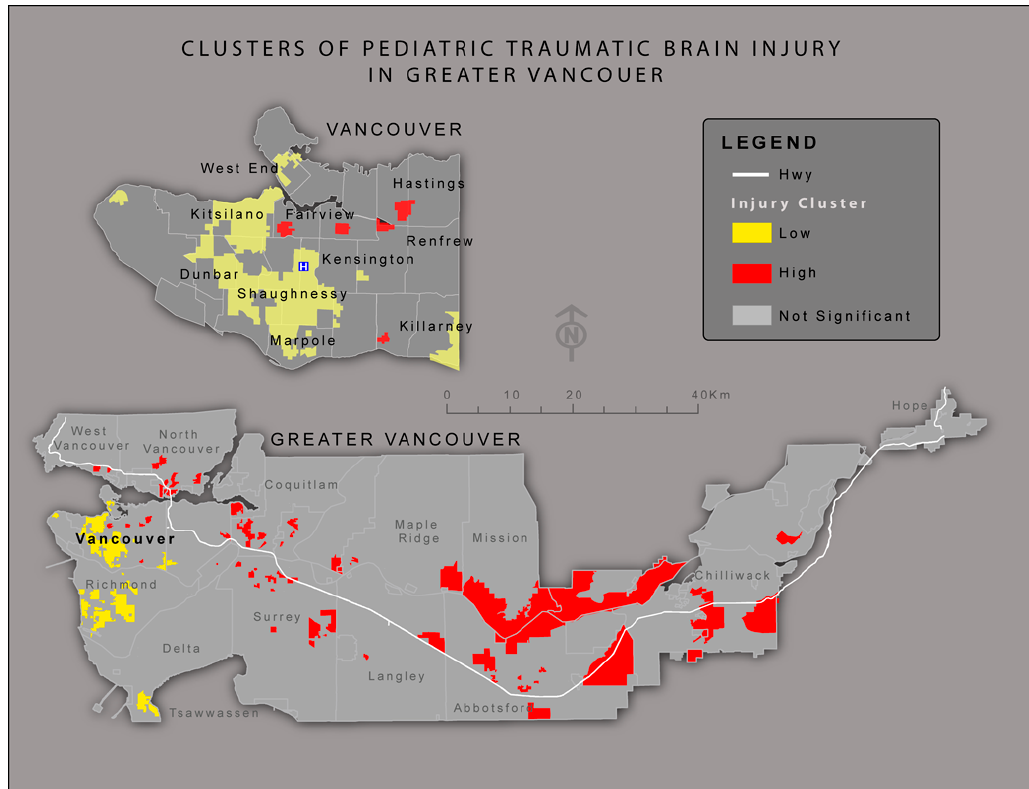
Figure 1. Map showing pediatric TBI clusters of high and low significance within greater Vancouver. High rate clusters tend to be concentrated to the east, while low rate clusters are most common in the west of the region. This pattern directly corresponds to Socio Economic Status (SES) values for the areas: the west side of Vancouver has consistently higher SES values as illustrated.